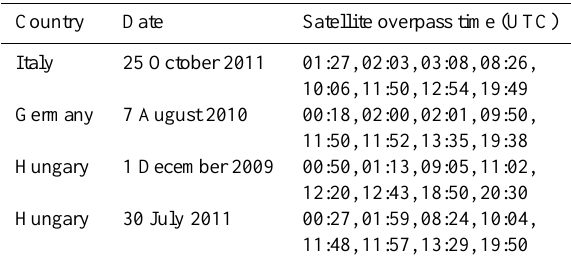
Table 4. Satellite overpasses (UTC times) utilized in the binned